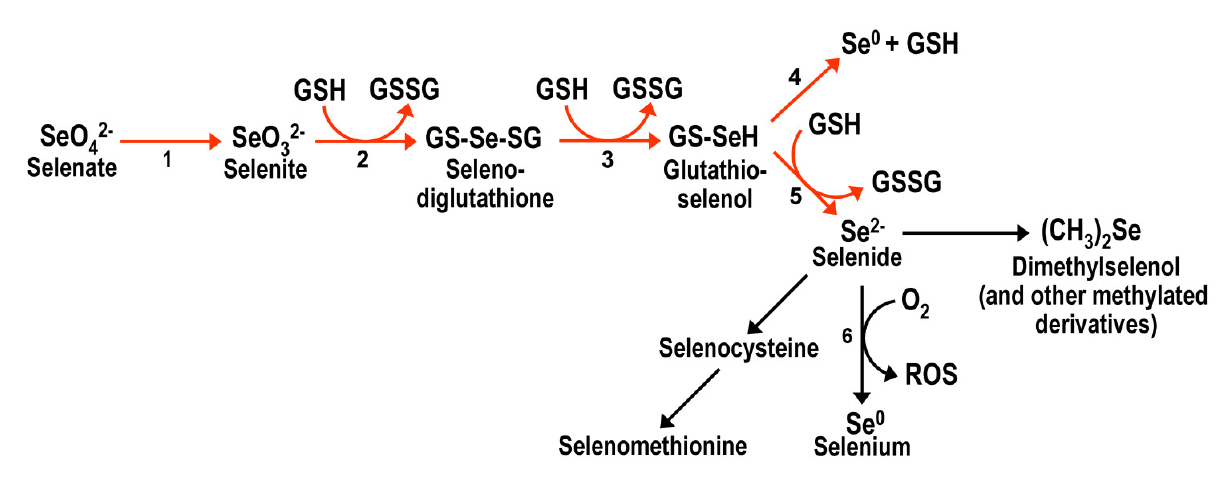
FIGURE 1: Scheme for the metabolic reduction of inorganic selenium forms, and their conversion into organic forms. Reductive reactions are indicated with red arrows. Arrow 1 corresponds to the reactions involving ATP sulfurylase and other enzymes that take part in the initial steps of the sulfate assimilation pathway. Reactions 2 to 5 are non-enzymatic and result in the net conversion of reduced glutathione (GSH) into oxidized glutathione (GSSG). Reaction 6 is also non-enzymatic and results in the formation of diverse reactive oxygen species. Adapted from [25], [26], [27] and